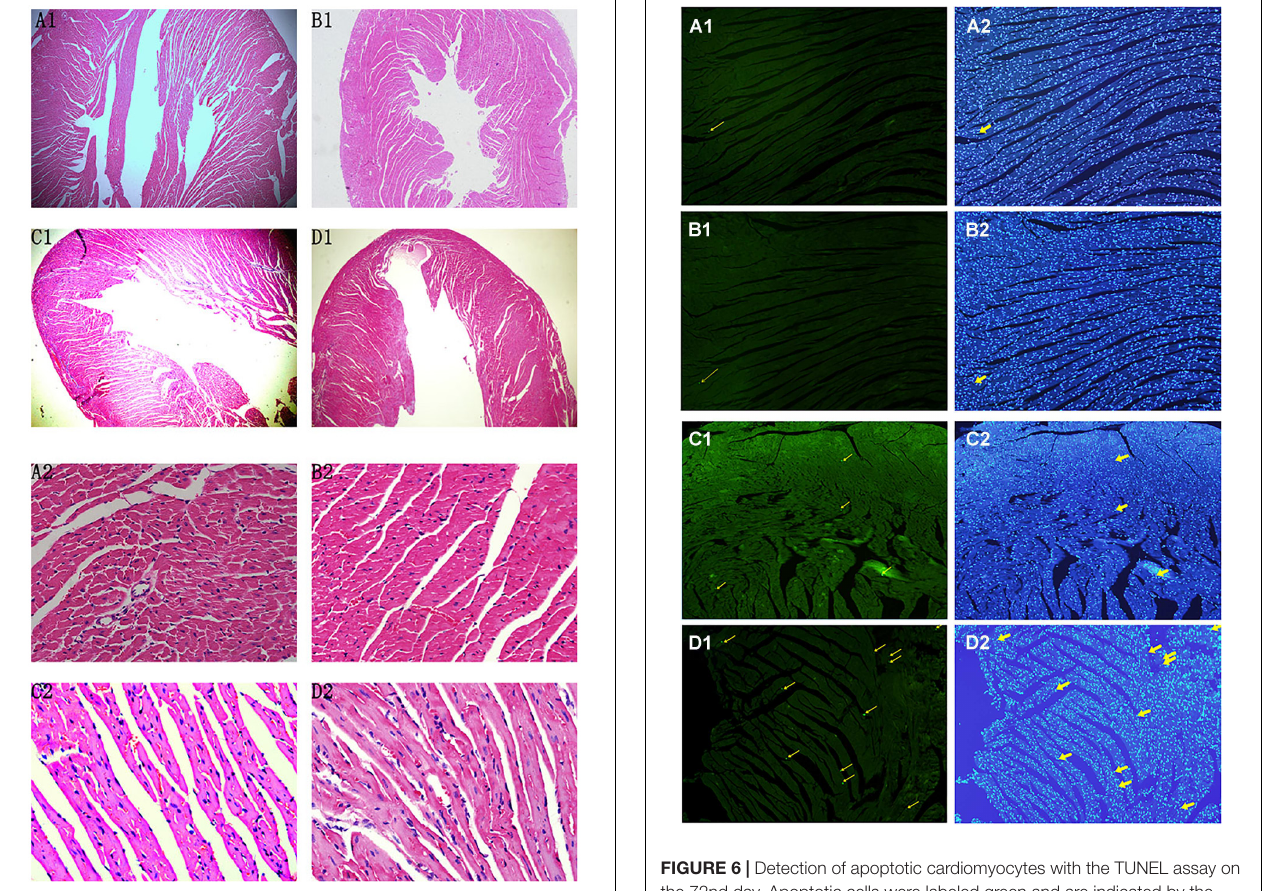
Frontiers in Pharmacology |